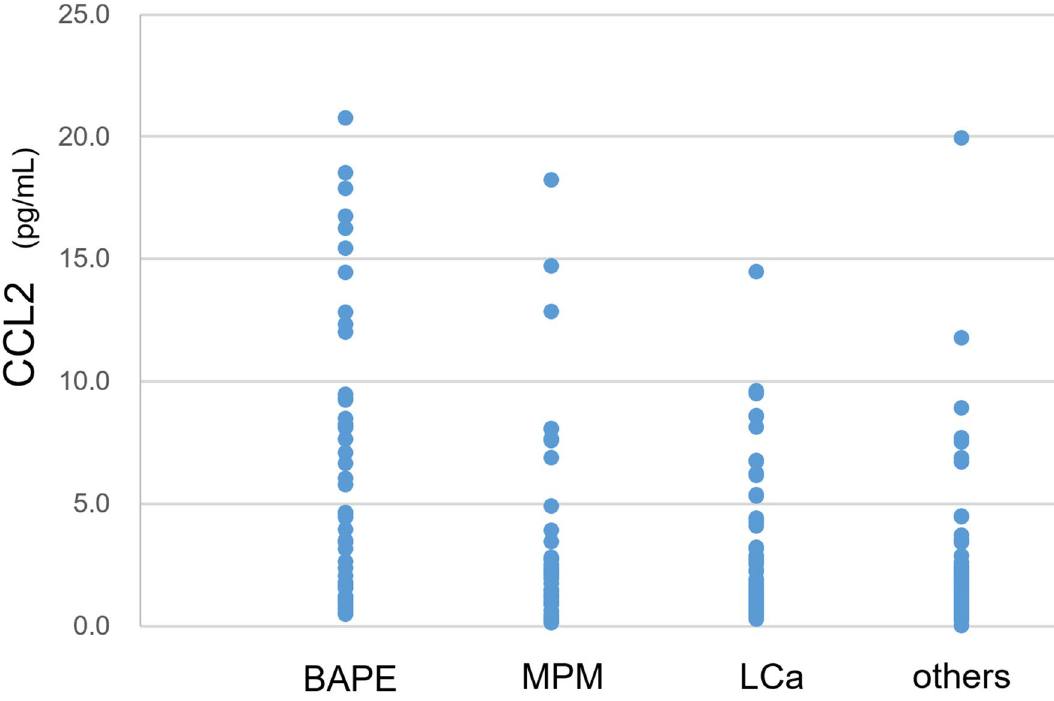
Figure 4. CCL2 levels in pleural effusion from patients with BAPE, MPM, LCA and other diseases. CCL2 C–C motif chemokine 2, BAPE benign asbestos pleural effusion, MPM malignant pleural mesothelioma, LCA lung cancer.